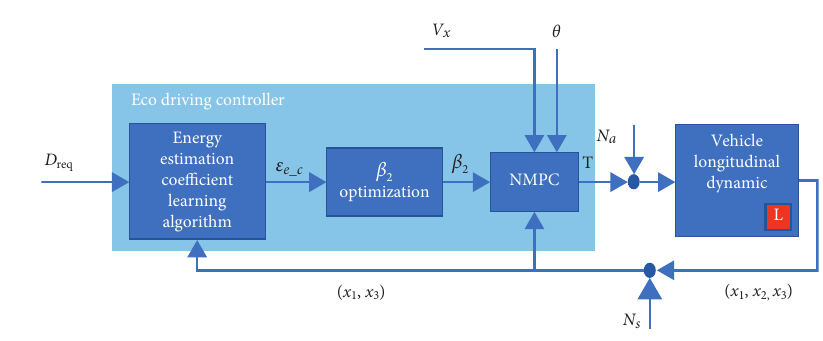
Figure 5: Control